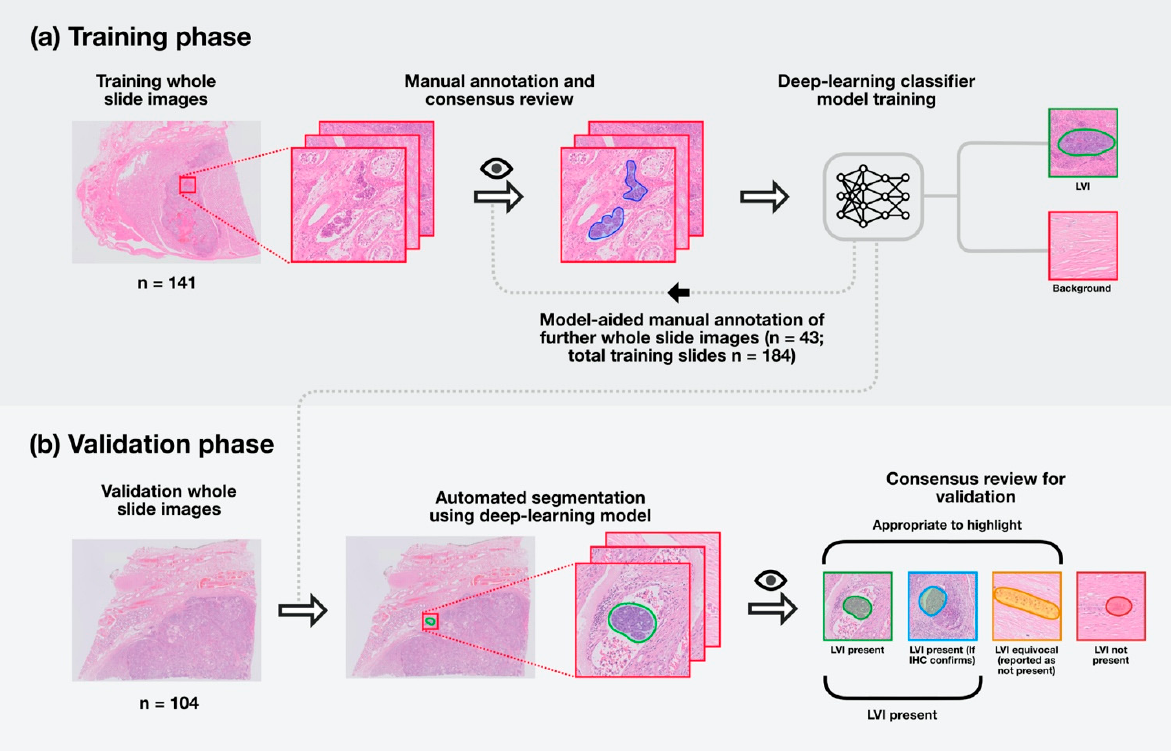
Figure 1. Summary of training and testing of a deep-learning segmentation model for identifying regions of lymphovascular invasion (LVI) in testicular cancer. ( a ) One hundred and forty-one digitised whole slide images were annotated manually, and consensus review by expert pathologists was performed to determine foci appropriate to use for training. These foci were used to train a deep-learning classifier to segment areas with a high prediction probability for LVI. The trained model was applied to a further 43 digitised whole slide images, which were again manually reviewed by specialist uropathologists, and the resulting annotations were used to tune the classifier. The total training set included 184 whole slide images from 19 patients. ( b ) One hundred and four digitised whole slide images from nine distinct cases were used for final validation. Each image was processed through the classifier, and the detected foci were reviewed independently by three specialist pathologists. A majority vote was used to determine ground truth as to areas appropriate to highlight and areas with LVI present.